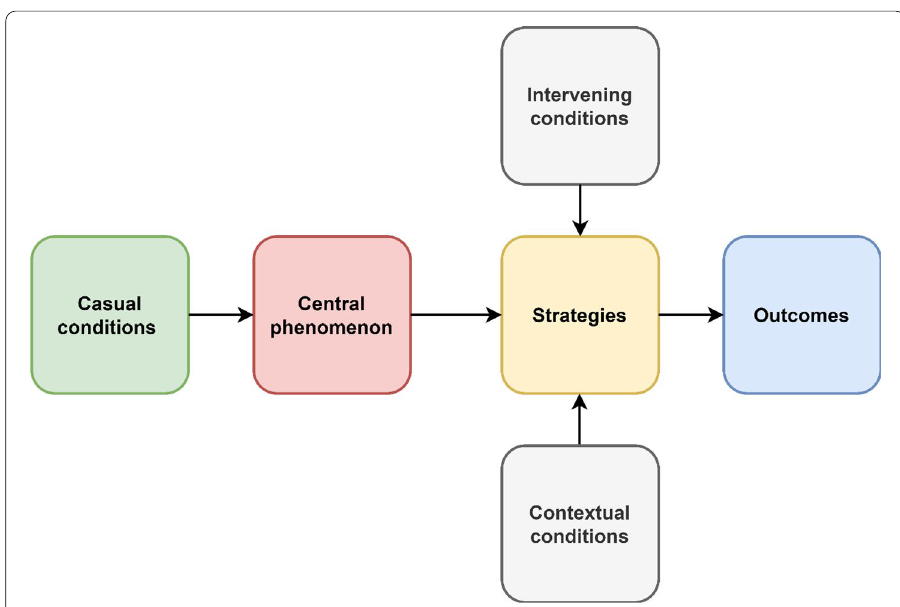
Fig. 1 The model of the axial coding based on Grounded Theory (Corbin & Strauss, 2014)